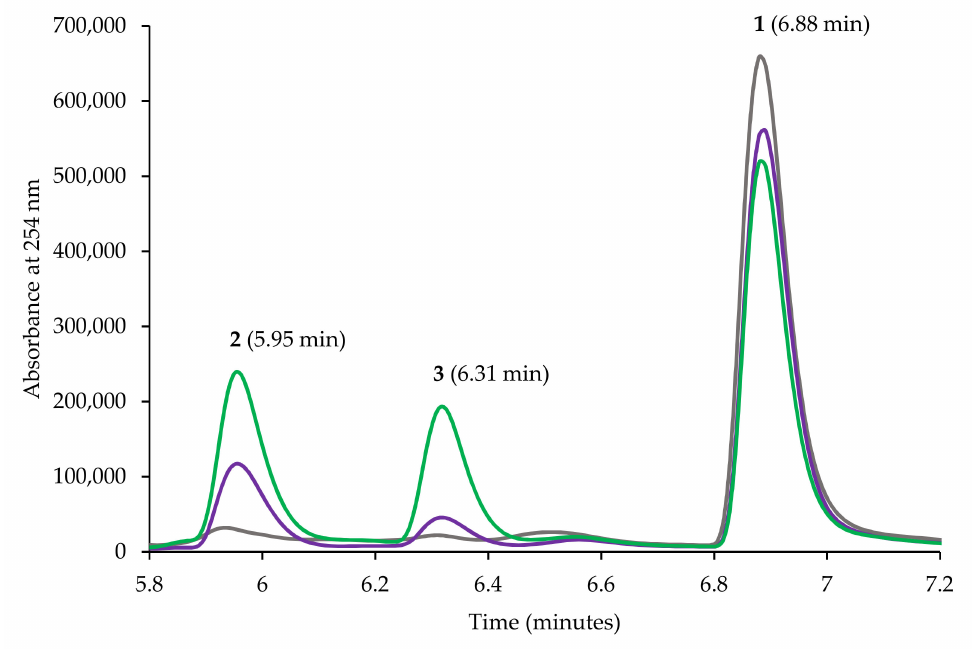
Figure 3. Bioreactor biotransformation conversion of 1 sample chromatograms at time points 0 h (grey line), 7 h (purple) and 26 h (green). Due to greater absorbance of 3 at 256 nm, the chromatographic peak is larger.